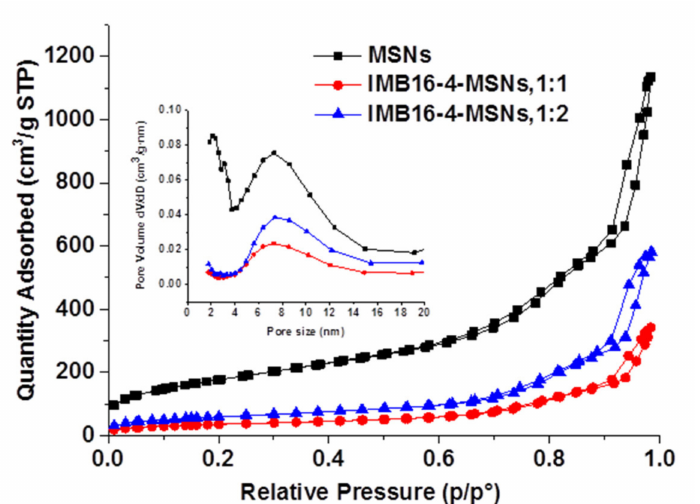
Figure 2. N 2 adsorption–desorption isotherms and the pore size distribution of MSNs and loaded samples